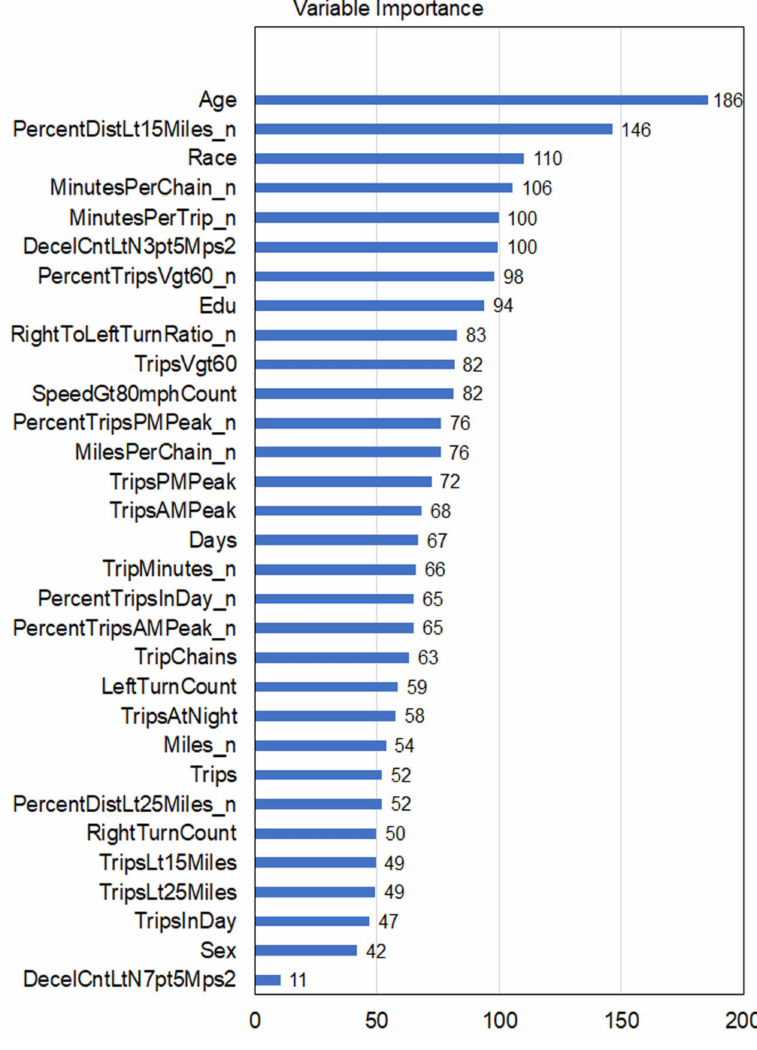
Figure 1. Feature importance